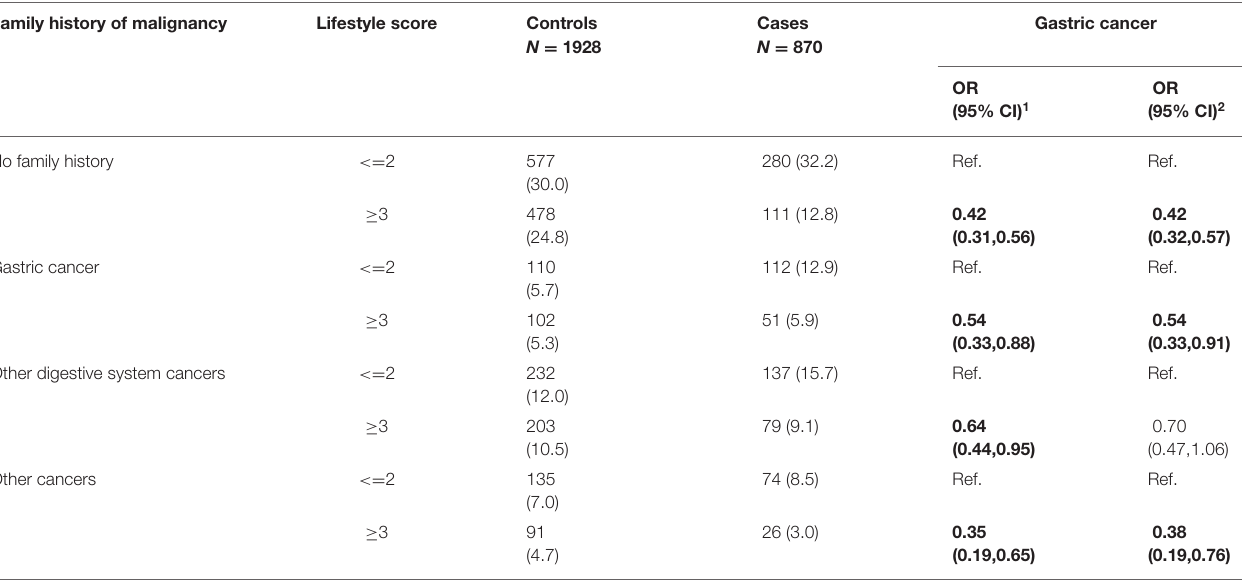
TABLE 5 | Association between lifestyle score and the risk of gastric cancer stratified by family history of malignancy. Family history of malignancy Lifestyle score Controls